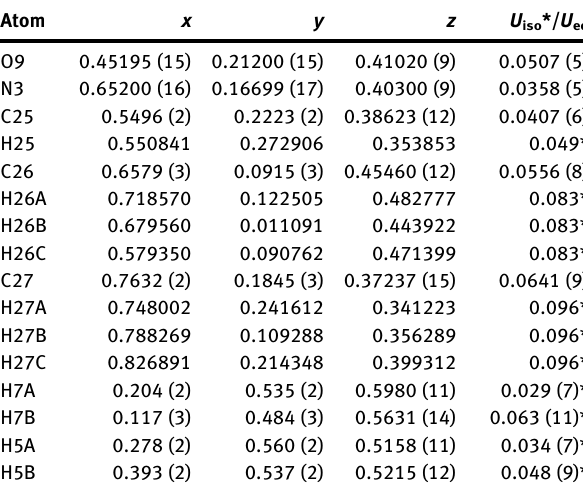
Table  : Fractional atomic coordinates and isotropic or equivalent isotropic displacement parameters (Å 